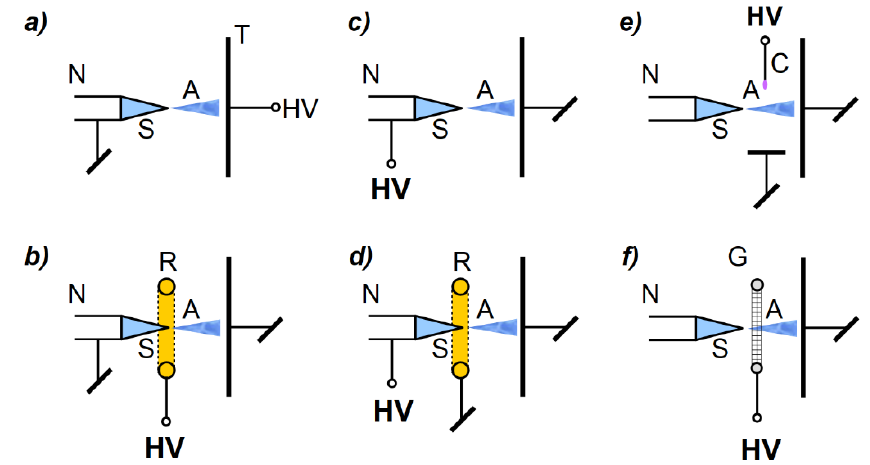
Figure 1. Schematic view of aerosol charging methods, requiring external high voltage source: ( a ) induction method in a 2-electrode system, ( b ) induction method in a 3-electrode system, ( c ) conduction method in a 2-electrode system, ( d ) conduction method in a 3-electrode system, ( e ) corona discharge method, and ( f ) postdispersion method. The main components of the system are: N — conducting nozzle acting as electrode; S — stream of liquid; A — aerosol; T — target; HV — high voltage source; C — corona electrode; R — ring electrode; G — grid electrode.